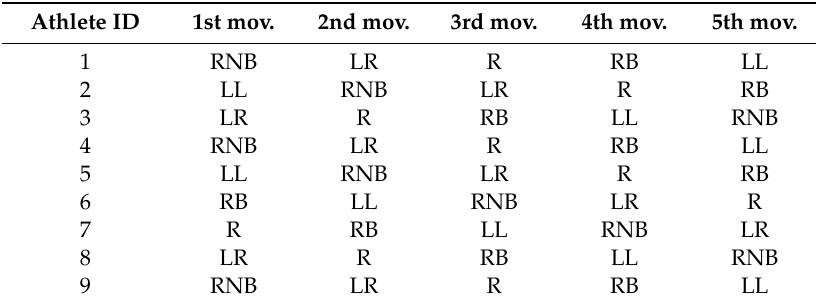
Table 2. Movement